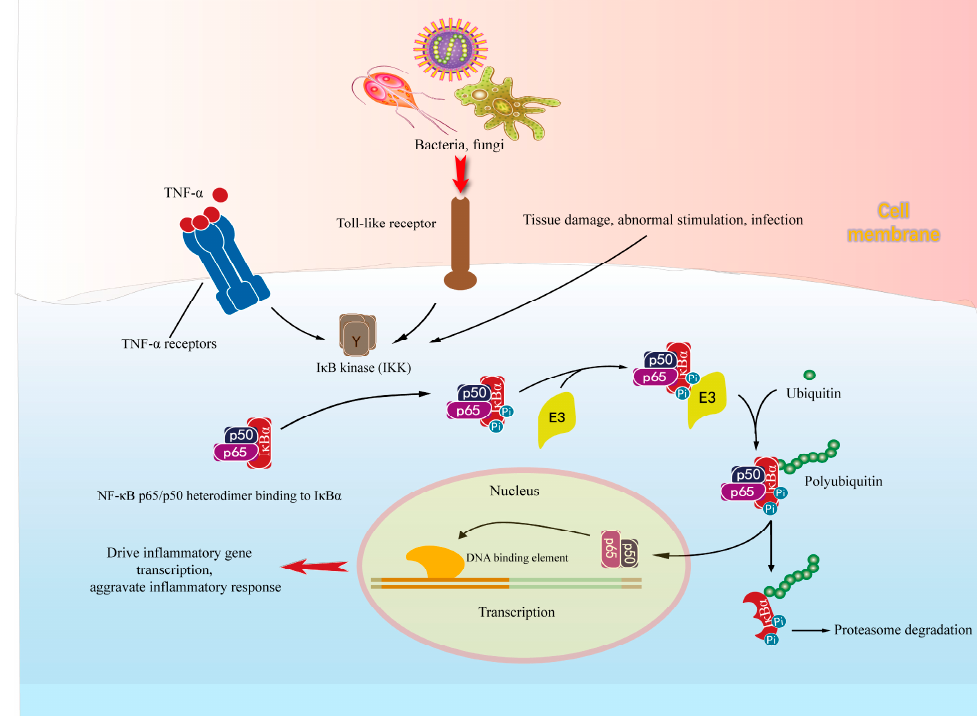
Figure 3. Activation and mechanism of NF- κ B in neuroinflammation . .